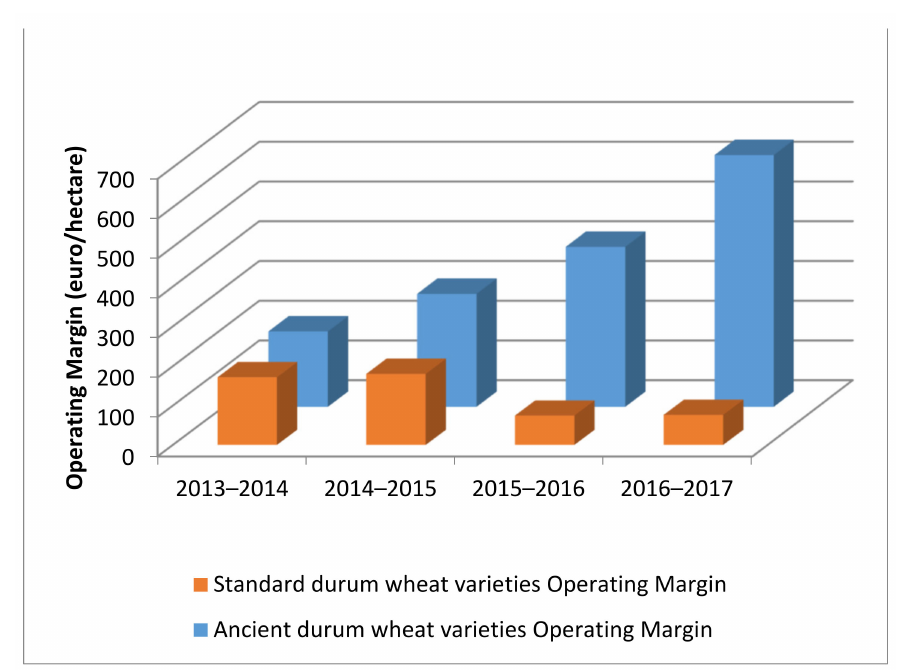
Figure 4. Comparison based on Operating Margin (OM), (average period